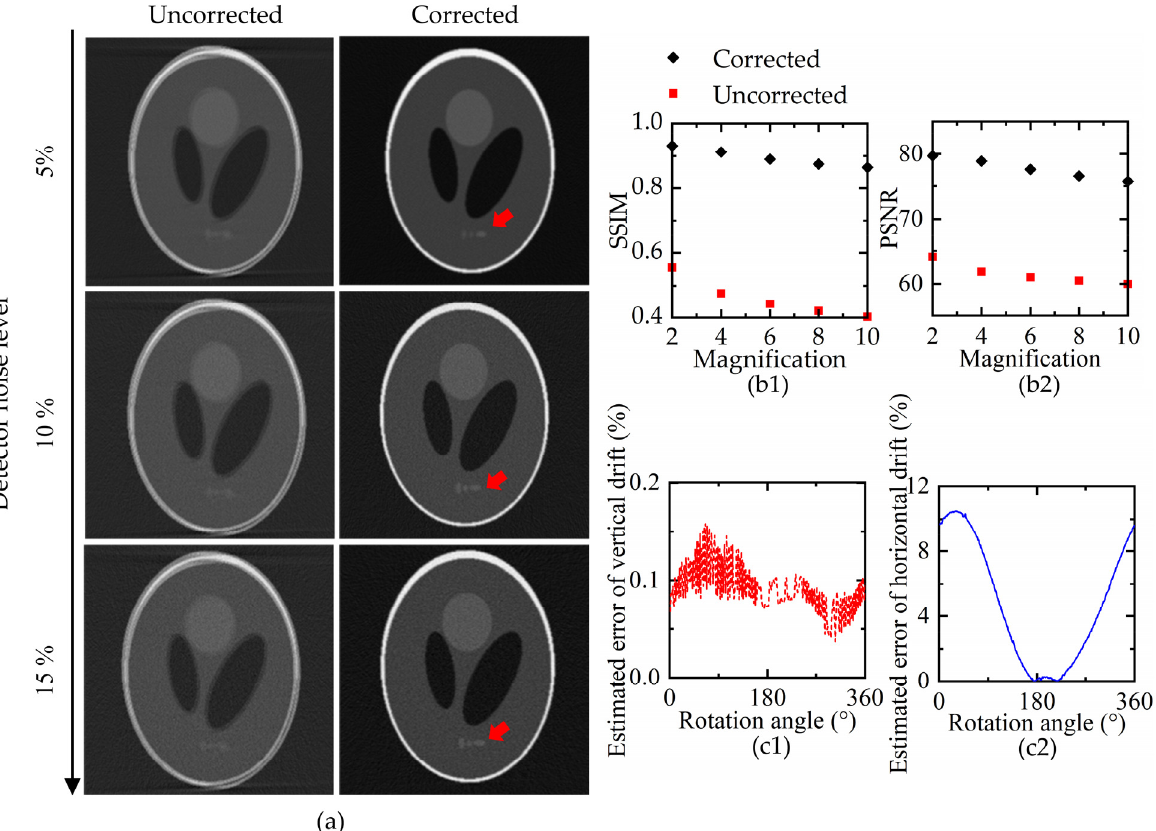
Figure 7. A performance evaluation. ( a ) The results of reconstructed slices with different noise lev- els; ( b1 , b2 ) the numerical evaluation of reconstructed slices at different drift levels; ( b1 ) SSIM; ( b2 ) PSNR; ( c1 , c2 ) elimination error in the case of 10 times drift amplitude; ( c1 ) vertical estimation error; ( c2 ) horizontal estimation error.